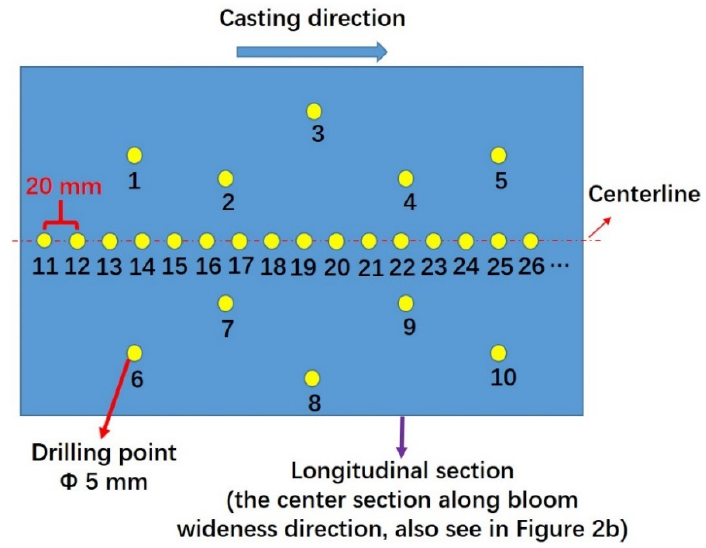
Figure 7. Drilling point positions of longitudinal section for segregation evaluation.